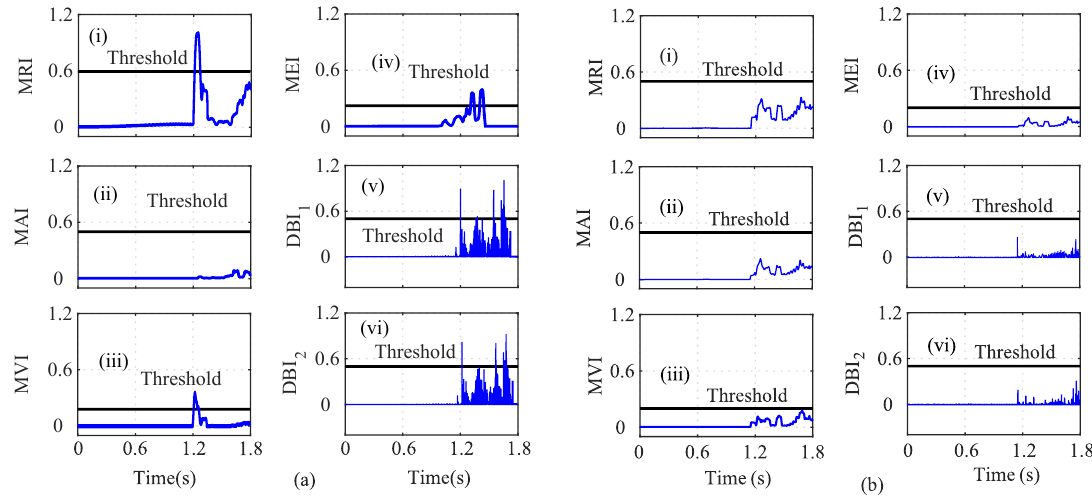
Figure 12. Analysis of residuals for ( a ) i α and ( b ) i β using index-based method ((i) MRI, (ii) MAI, (iii) MVI, (iv) MEI, (v) DBI 1 and (vi) DBI 2 ) for the 20% noisy incipient i α fault and abrupt W e fault scenario at t = 1.25 s and t = 1.50 s, respectively.